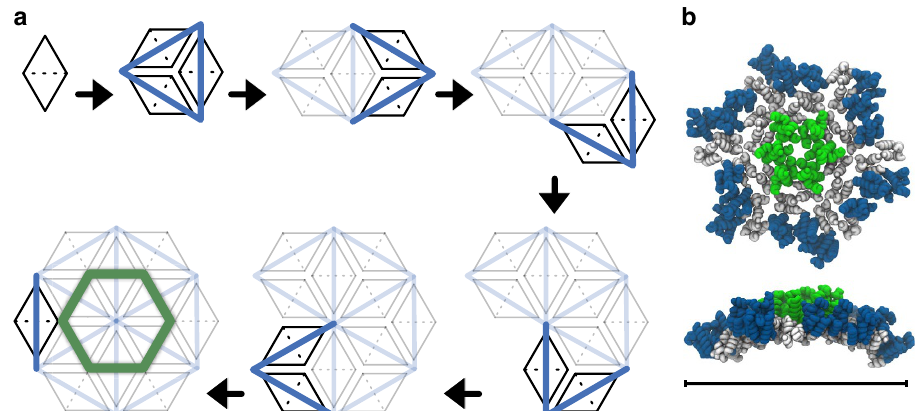
Figure 4 | Putative assembly from 12 CA dimers that nucleates CG capsid lattice growth. ( a ) Reversible addition of CA dimers (CA monomers depicted as black triangles, CTD/CTD interface as a dashed line) onto existing aggregates produces trimers with shared edges, eventually generating a central hexamer stabilized by trimer ‘skirt’. ( b ) Front and side view of example structure from CG simulation, with mild innate curvature visible. Hexamer- associated NTDs are green, NTDs in trimer skirt blue, CTDs grey. Scale bar,